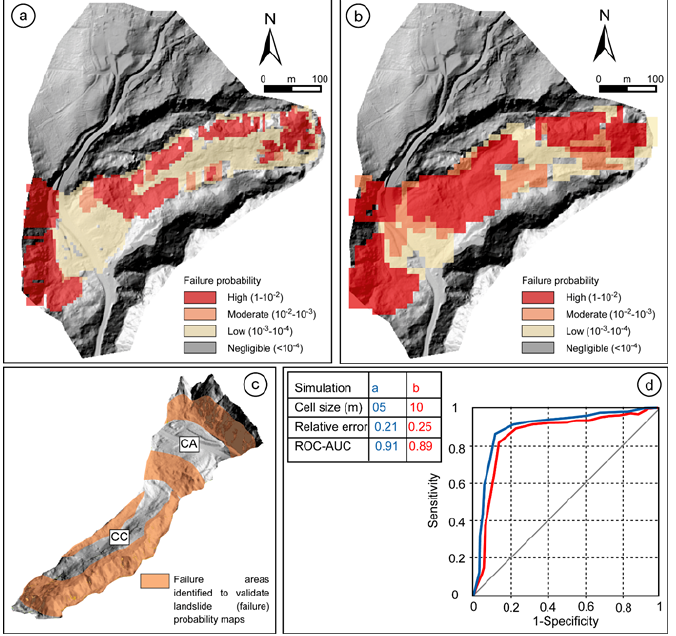
Figure 11. Comparison of results with cell sizes of 5 m and 10 m for the La M é daille landslide. ( a ) Map computed with a cell size of 5 m; ( b ) map computed with a cell size of 10 m. ( c ) Expert map of potential failures; ( d ) statistical tests for ( a , b ). For each computation for ( a , b ), the GWL = 1. Hillshade maps were produced with the Helimap DTM